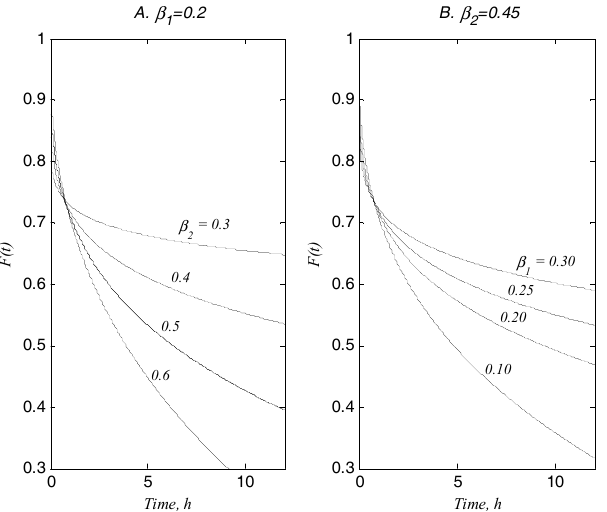
Figure 1. Moisture distributions affected by the orders of fractional derivatives in Equation (14). ( A ): Fixed β 1 with variable β 2 indicating the facilitating role of β 2 in large pores; ( B ): fixed β 2 with variable β 1 indicating the trapping role of β 1 in small pores. In both cases, the joint parameter is K 1 = 0.01.